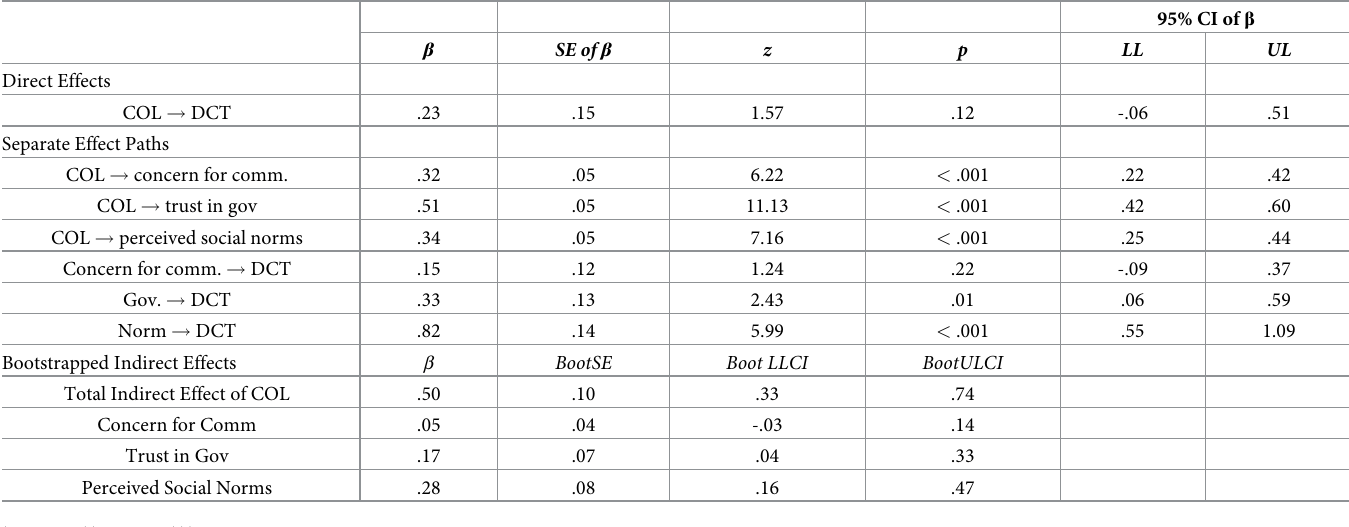
Table 6. Regression coefficients for mediation models (DCT).